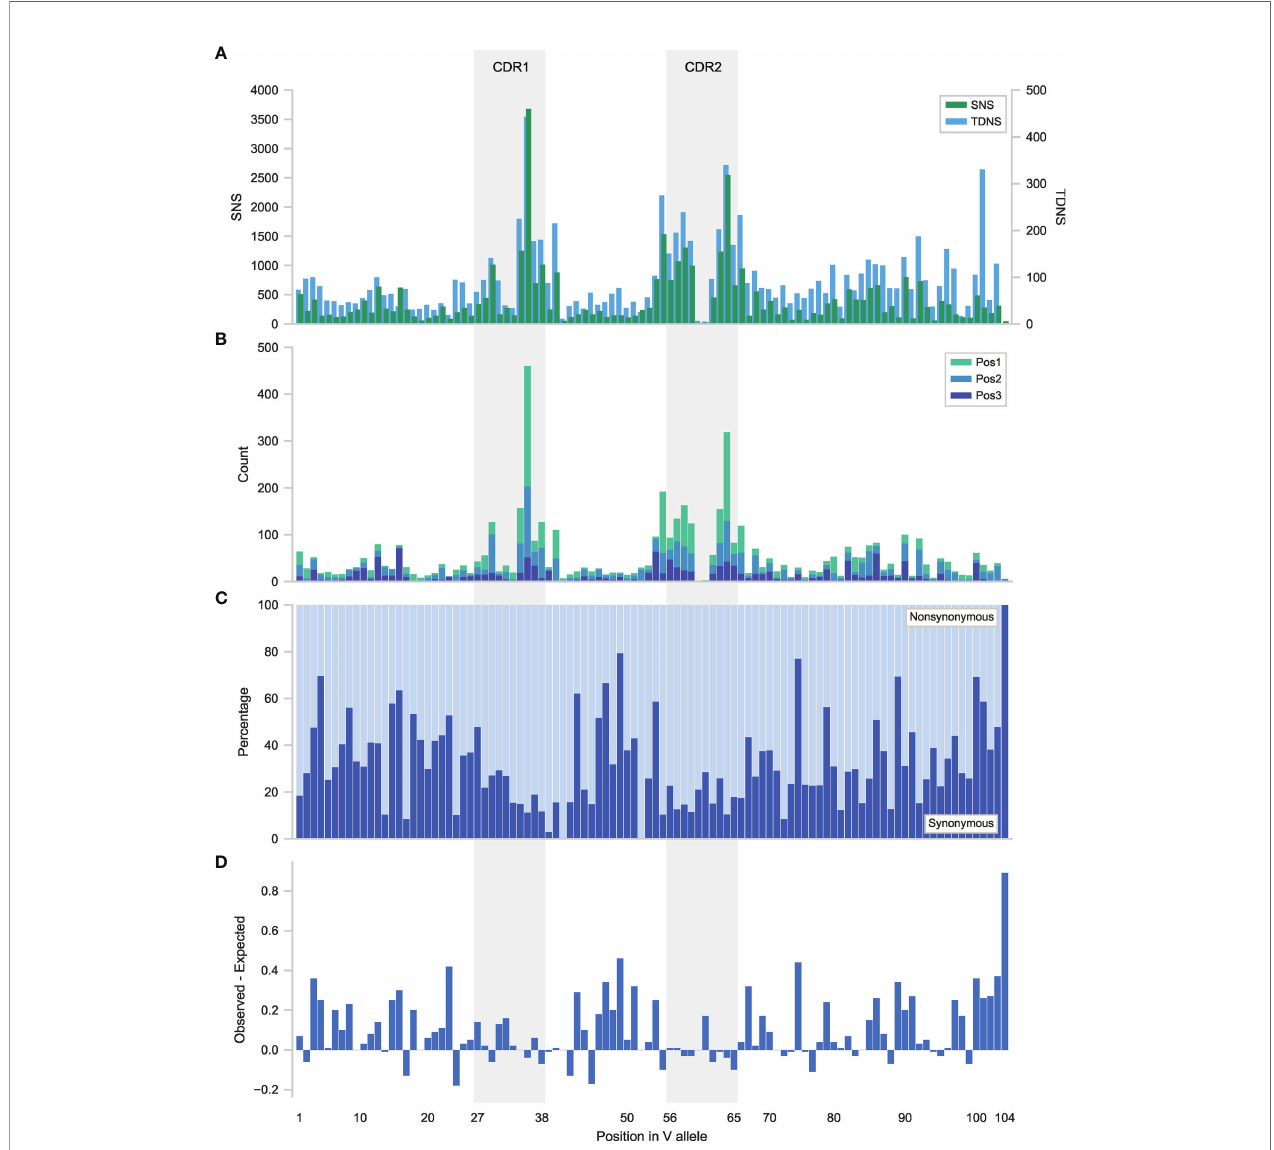
FIGURE 2 | Distribution of tandem dinucleotide substitutions in the IGHV allele. (A) Distribution of single nucleotide substitutions (SNS) and tandem dinucleotide substitutions (TDNS) in the V allele. Amino acid positions 30-32 and 60-61 in CDR1 and CDR2 respectively, are present in only a small minority of V alleles and therefore mutations in these positions are rare events when considering the whole sequence library. (B) Nucleotide speci fi c context within a codon. Relative contributions of tandem dinucleotide substitutions for VDJ. Results are split per position in the codon. Position 1 represents 5 ’ and middle base on the coding strand, position 2 represents middle and 3 ’ base and position 3 represents the 3 ’ base of the codon and the 5 ’ base of the downstream codon. (C) Proportion of synonymous and nonsynonymous mutations per position in the V allele. (D) Mutational resistance score. Plotted are the expected minus the observed frequencies of nonsynonymous mutations per codon position in the V allele. Increasingly higher values represent residues that are more resistant to